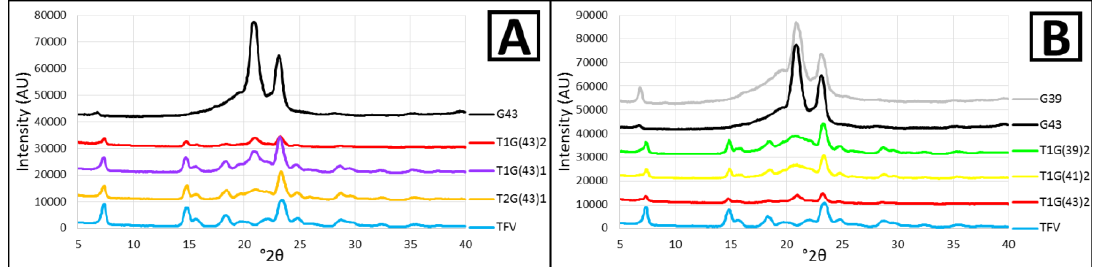
Figure 5. X-ray diffraction patterns of pure TFV, G43 and their combinations ( A ); and TFV, G43, G39 and their combinations in a ratio of 1:2 TFV/Gelucire® ( B ).